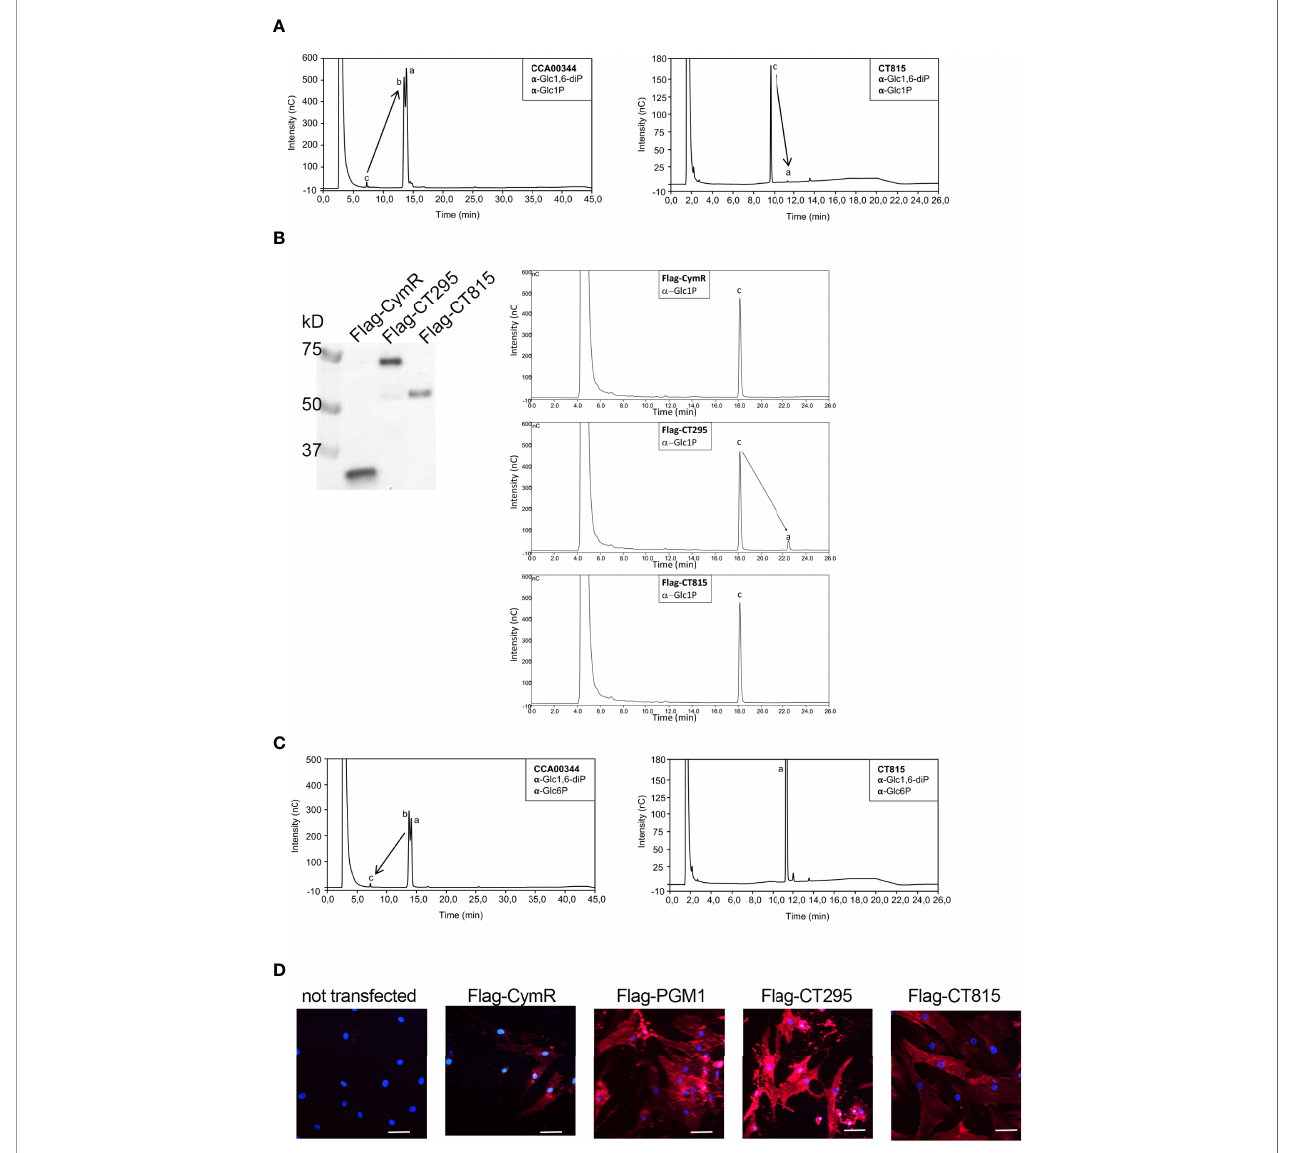
FIGURE 3 | CT295 is a phosphoglucomutase. (A) – The indicated puri fi ed proteins (bold letters) were incubated with Glc1P in the presence of the co-factor Glc1,6diP. The substrates and reaction products were identi fi ed by HPAEC. Incubation of Glc1P (peak c) with CCA00344 resulted in full conversion into Glc6P (peaks a and b), while Glc6P was hardly detectable when CT815 was tested. Note that the samples were run on two different columns, resulting in different elution pro fi les. (B) – The indicated Flag-tagged proteins expressed by transfection in HEK293T cells were immobilized on beads and used to perform enzymatic assay as in A (in the absence of Glc1,6diP) ( right ). A fraction of the transfected cell lysates was analyzed by western blot using anti-Flag antibodies ( left ). (C) – The reverse reaction was tested using puri fi ed proteins as in A. A very low conversion of Glc6P into Glc1P was observed for CCA00344 and was totally absent for CT815. Of note, CCA00344 favors the conversion of a -Glc6P (peak a) into b -Glc6P (peak b) while CT815 does not. (D) – PGM1 de fi cient fi broblasts were transfected or not with the indicated constructs. One day later, ICAM1 expression at the cell surface was probed with Cy5-coupled anti-ICAM1 antibody (red). Nuclei were stained with Hoechst (blue). Bar is 50 m